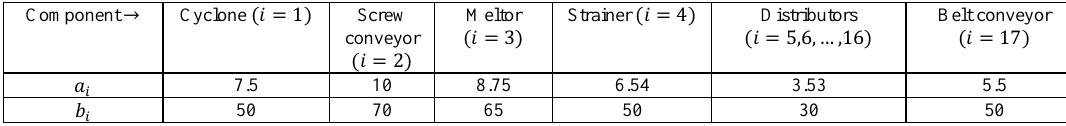
’s and 𝑏 ’s for prilling and carbon recovery 𝑖 𝑖